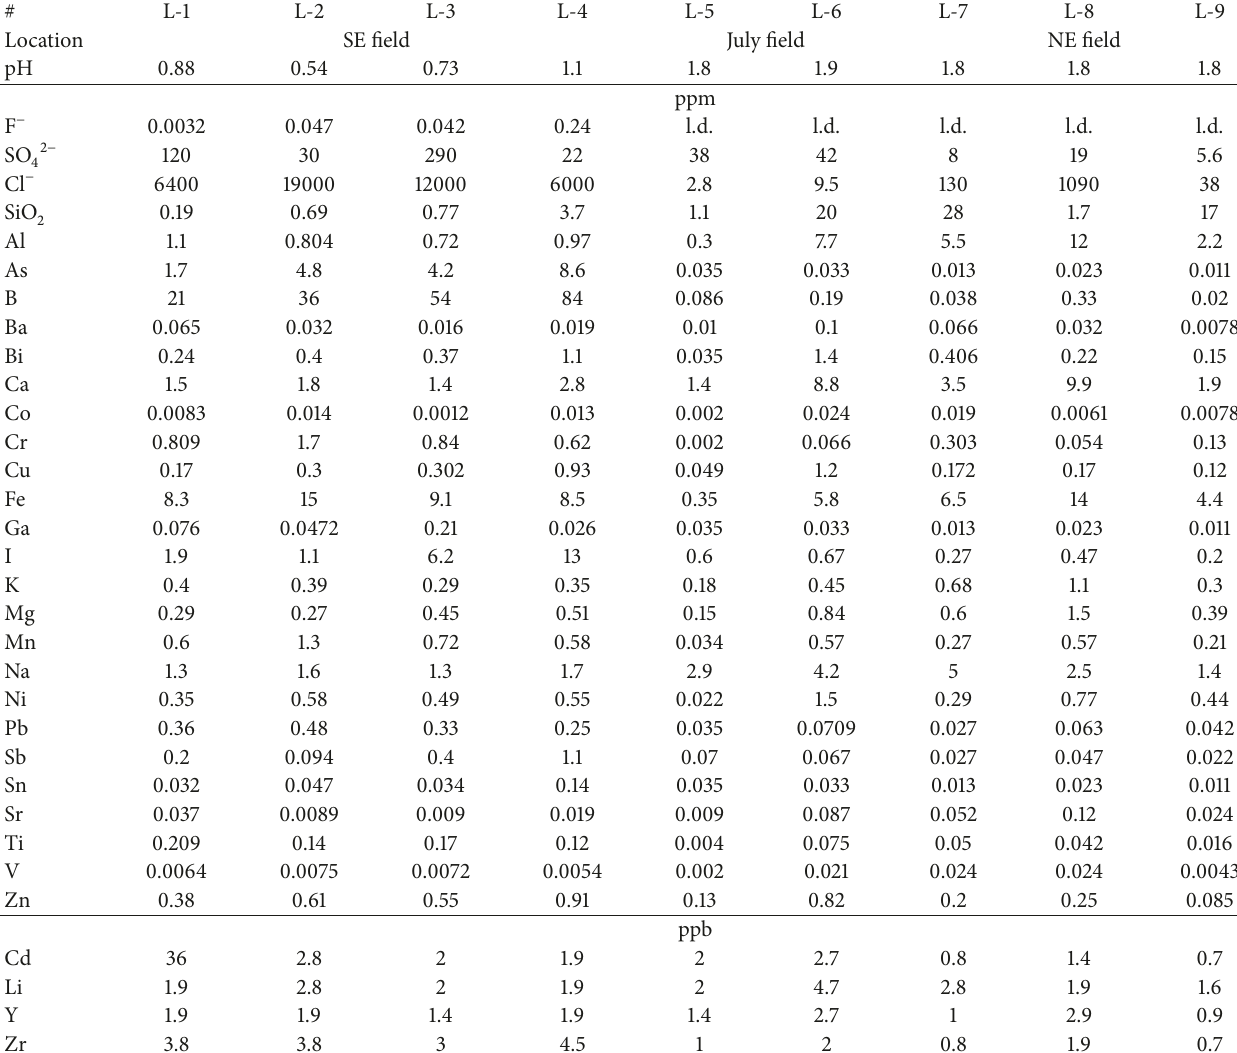
Table 3: Concentrations of anions and cations in sulfur